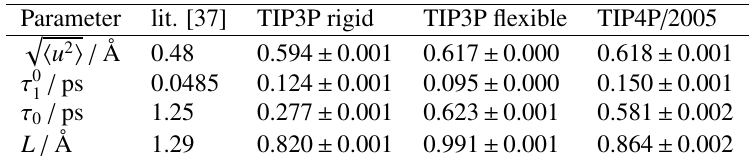
Figure 6. Fit of I ( Q , t ) computed from the TIP3P rigid (left), TIP3P flexible (middle), and TIP4P / 2005 rigid (right) simulations, shown as dots, with an analytic expression from the literature [37]. The best global fit of this formula is shown as drawn-out lines. Table 2. Parameters from fits to experimental data published in the literature [37] compared to the values obtained from fits to the intermediate scattering patterns computed in this work for both TIP3P and the TIP4P / 2005 rigid water